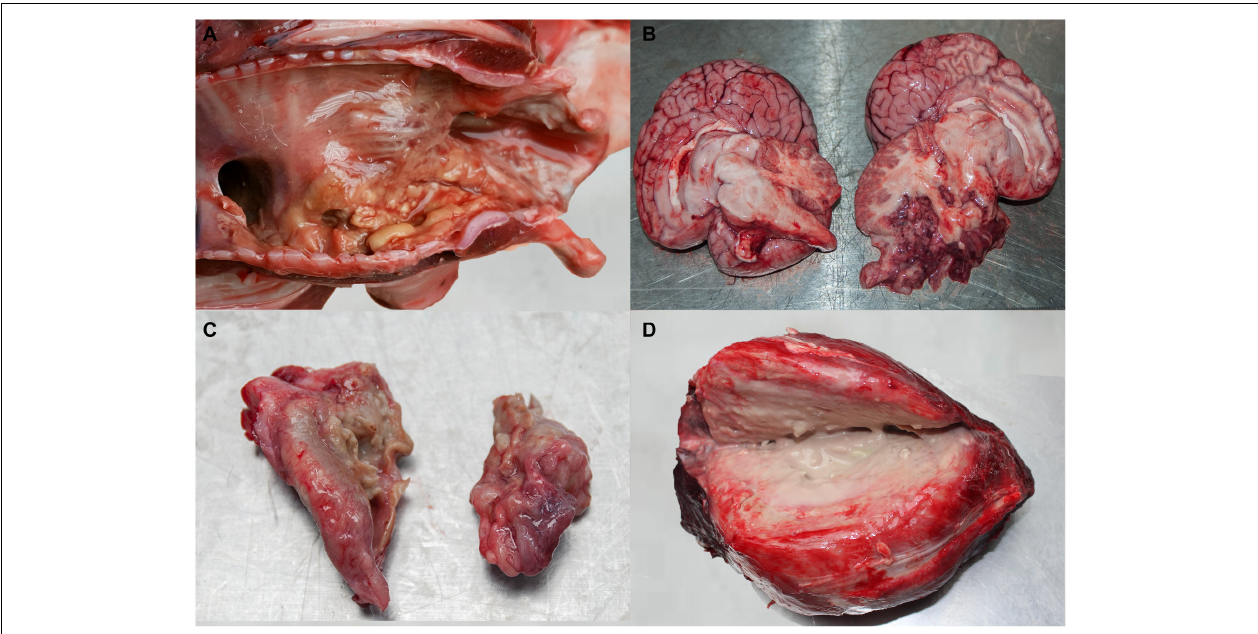
FIGURE 2 | (A) Granular, irregular plaques in the bronchi of case #18. (B) Purulent meningoencephalitis demonstrated by purulent exudate in the cranium after removal of the brain in case #1. (C) Severe necro-purulent otitis in case #15 (left side). (D) Large, purulent and necrotic mass from abdominal cavity of case #9 (size: 20 × 20 × 15